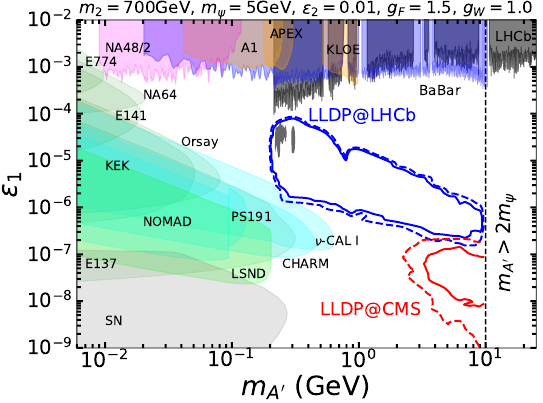
Figure 9 . LHC current and future sensitivity contours to the LLDP parameter space spanned by (cid:15) 1 and the dark photon mass. We take m = 5 GeV and (cid:15) 2 = 0 : 01. The blue solid and dashed contours indicate the regions probed by the LHCb with 5 : 5 fb (cid:0) 1 and 15 fb (cid:0) 1 data respectively. The regions probed by the future MTD CMS with 250 fb (cid:0) 1 and 3000 fb (cid:0) 1 data are shown as red solid and dashed contours respectively. The gray islands at (cid:15) 1 (cid:24) (10 (cid:0) 4 (cid:0) 10 (cid:0) 5 ) are the LHCb exclusion regions for the conventional dark photon scenario [64]. Various experimental constraints on the conventional dark photon scenario are shown as color shaded